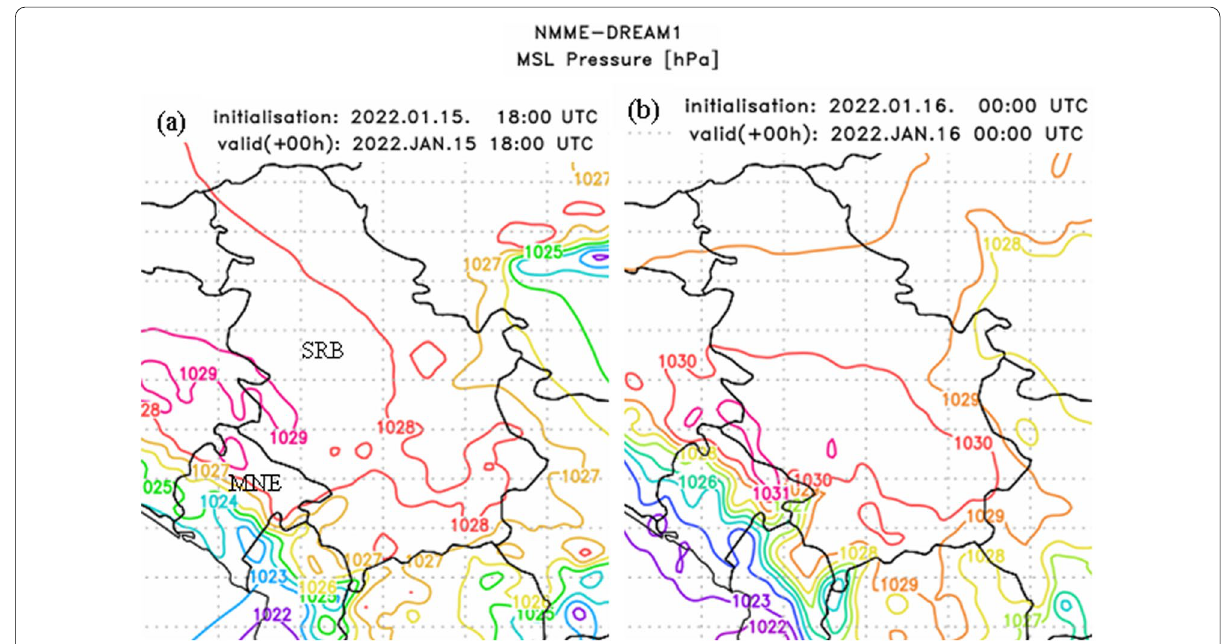
Fig. 5 Distribution of air pressure over Serbia (SRB) and Montenegro (MNE) at 18 UTC 15 January ( a ) and on 16 January at 00 UTC ( b )